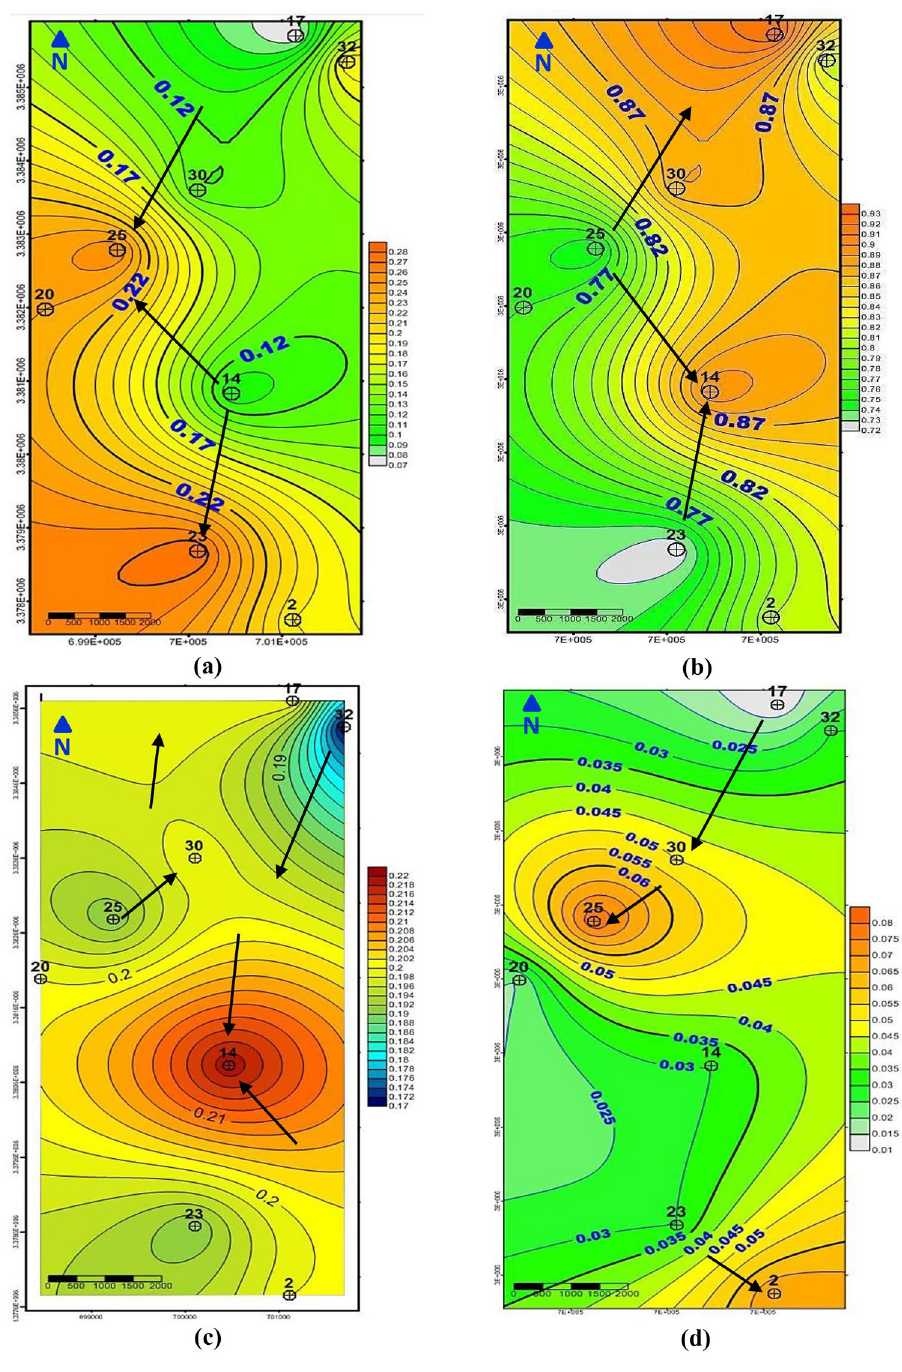
Fig. 11 Iso-parametric maps for the studied Albian sequence showing a the water saturation (Sw in 0.0), b oil saturation (So in 0.0), c effective porosity ( ∅ e in 0.0), and d the shale volume (Vsh in 0.0). Arrows refer to the direction of increasing